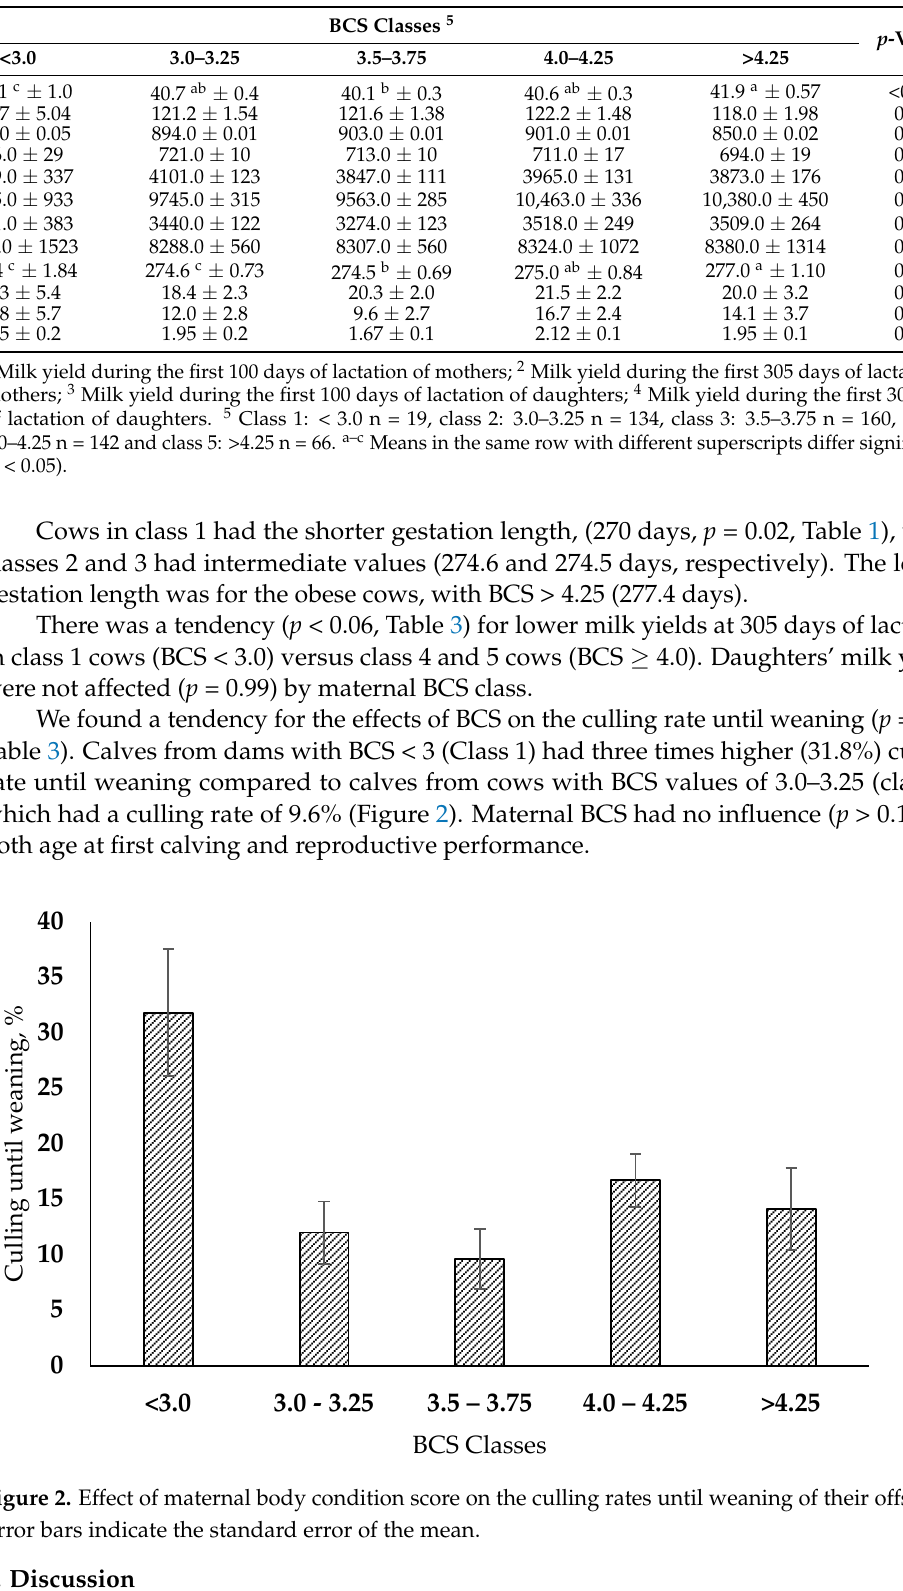
Table 3. Effect of body condition score at calving on the performance of cows and their offspring.